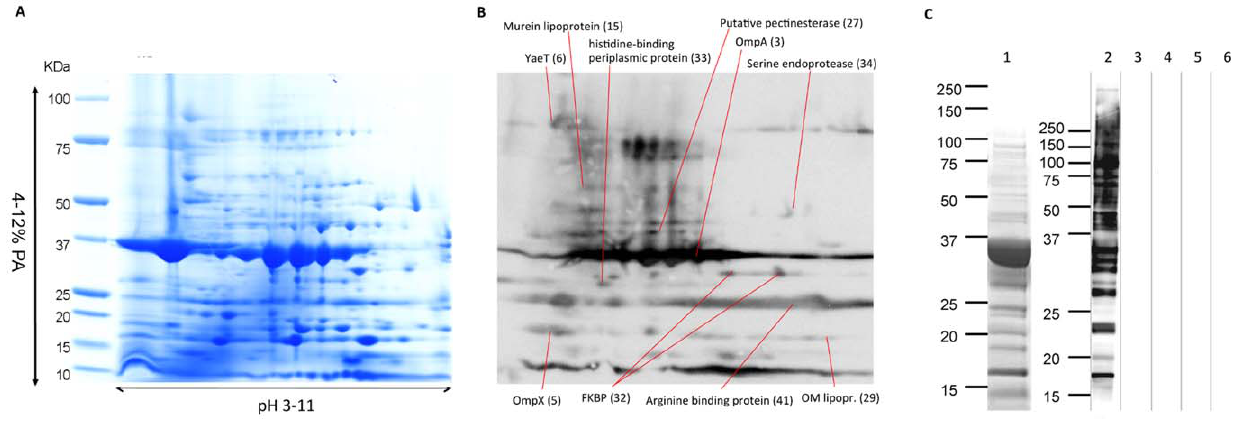
Figure 4. 2D gel electrophoresis of Shigellasonnei D tolR D galU GMMA and immunoblot. A)200 m g of proteins from S. sonnei D tolR D galU GMMA were separated in the first dimension on a non linear pH 3–11 gradient, and in the second dimension on a 4–12% polyacrylamide gradient. Visible bands were identified by protein mass fingerprint. OmpA and OmpC were quantified with Image master 2D Platinum 6.0. B) Sera from mice immunized with GMMA from S. sonnei D tolR D galU were used to study the subset of proteins present in GMMA that are able to raise antibodies. A 2D gel containing 20 m g of GMMA protein from S. sonnei D tolR D galU was blotted and the membrane was incubated with sera from immunized mice with GMMA from S. sonnei D tolR D galU in combination with Freund’s adjuvant. Several reactive proteins were identified. The numbers behind the names refer to the position of the proteins in Table 2. C) To verify that the signal observed in the 2D Western blot was due exclusively to antibody raised upon immunization with GMMA, 10 m g of GMMA were separated by 1D SDS-PAGE (12% PA) and stained with Coomassie (1) or transferred to a membrane. Western blots were developed using (2) sera raised against GMMA from S. sonnei D tolR D galU as used for the 2D Western blot in B, (3) preimmune serum, (4) sera raised in mice immunized with Freund’s adjuvant or (5) PBS, or (6) secondary antibody only. A signal could only be observed when sera raised against GMMA were used (2).